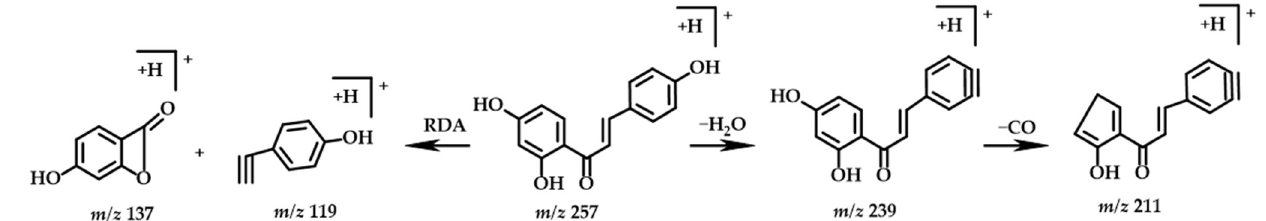
Figure 7. Chemical structure and fragmentation pathways of isoliquiritigenin.